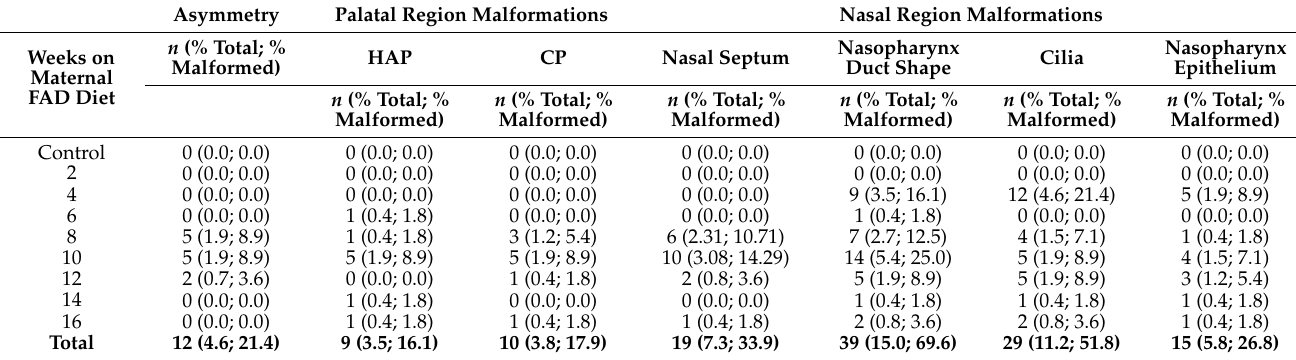
Table 2. Type and incidence of malformations per weeks on a maternal folic acid-deficient (FAD) diet. Asymmetry Palatal Region Malformations Nasal Region Malformations